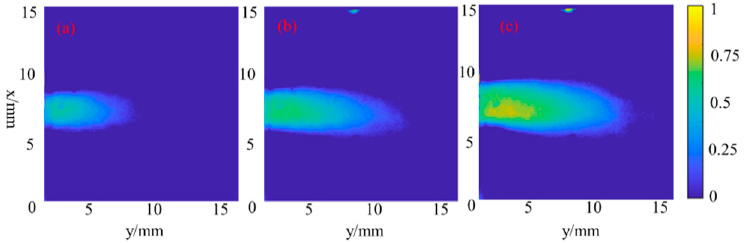
Figure 7. The cavitation intensity distribution of hydrodynamic-acoustic cavitation under the inlet pressure of 2 MPa ( a ) Without ultrasound ( b ) 250 W ( c ) 500 W.